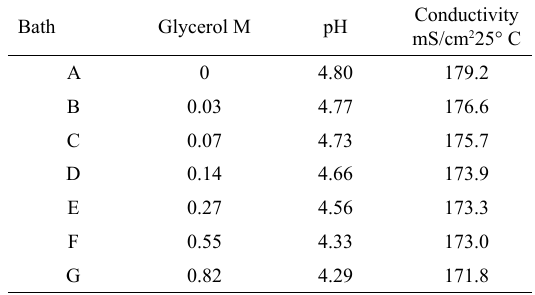
Table 3. pH and Conductivity data of the electrolytic